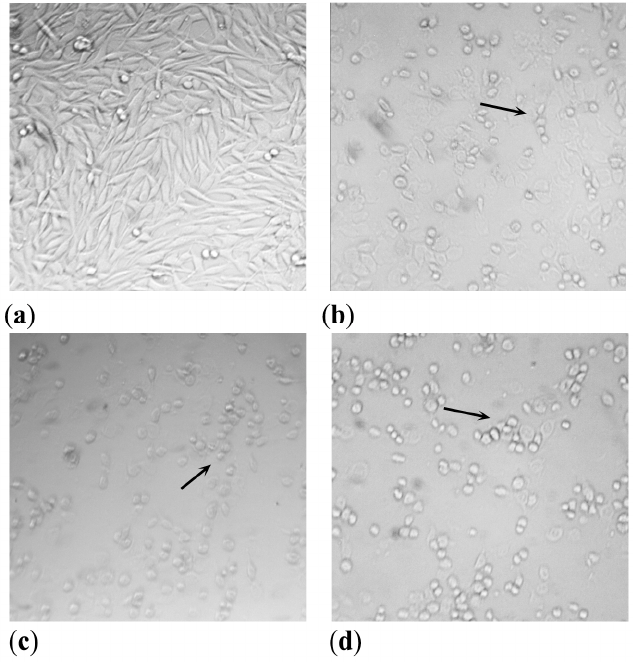
Figure 6. Melanoma C32 cells morphology 48 h after UVA irradiation at a dose of 1.08 J/cm 2 . ( a ) Control, untreated irradiated cells in RPMI 0.5% MeOH; ( b ) treated irradiated cells, P. ferulacea ex- tracted with maceration (TM), 50 μ g/mL; ( c ) treated irradiated cells, P. ferulacea extracted with Nav- iglio ® (PCSL), 50 μ g/mL; ( d ) treated irradiated cells, P. ferulacea L. extracted with supercritical CO 2 extraction (S-CO 2 ), 25 μ g/mL. Cells were visualized with an inverted microscope (AE20 Motic) and images were captured with a VisiCam digital camera. Arrows indicate rounded and shrunken cells. Magnification, 10×.